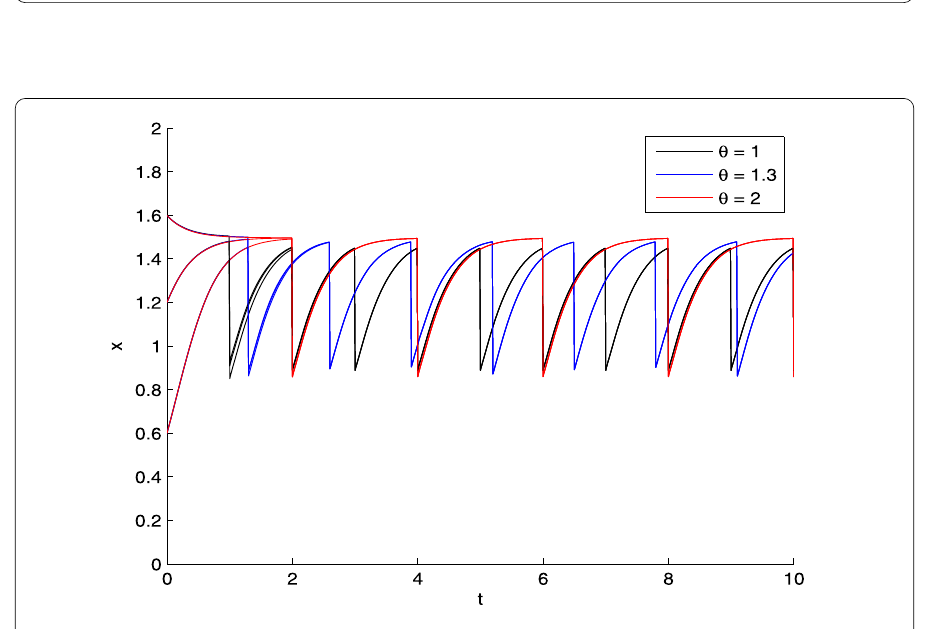
Figure 4 Dynamic behaviors of the species x ( t ) in system (1.4) with the initial conditions x (0) = 0.6, x (0) = 1.2, x (0) = 1.6,